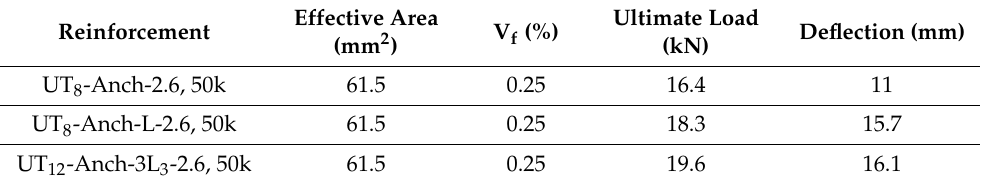
Table 9. Outcomes of TRC beams having the same cross-section area and various layers.